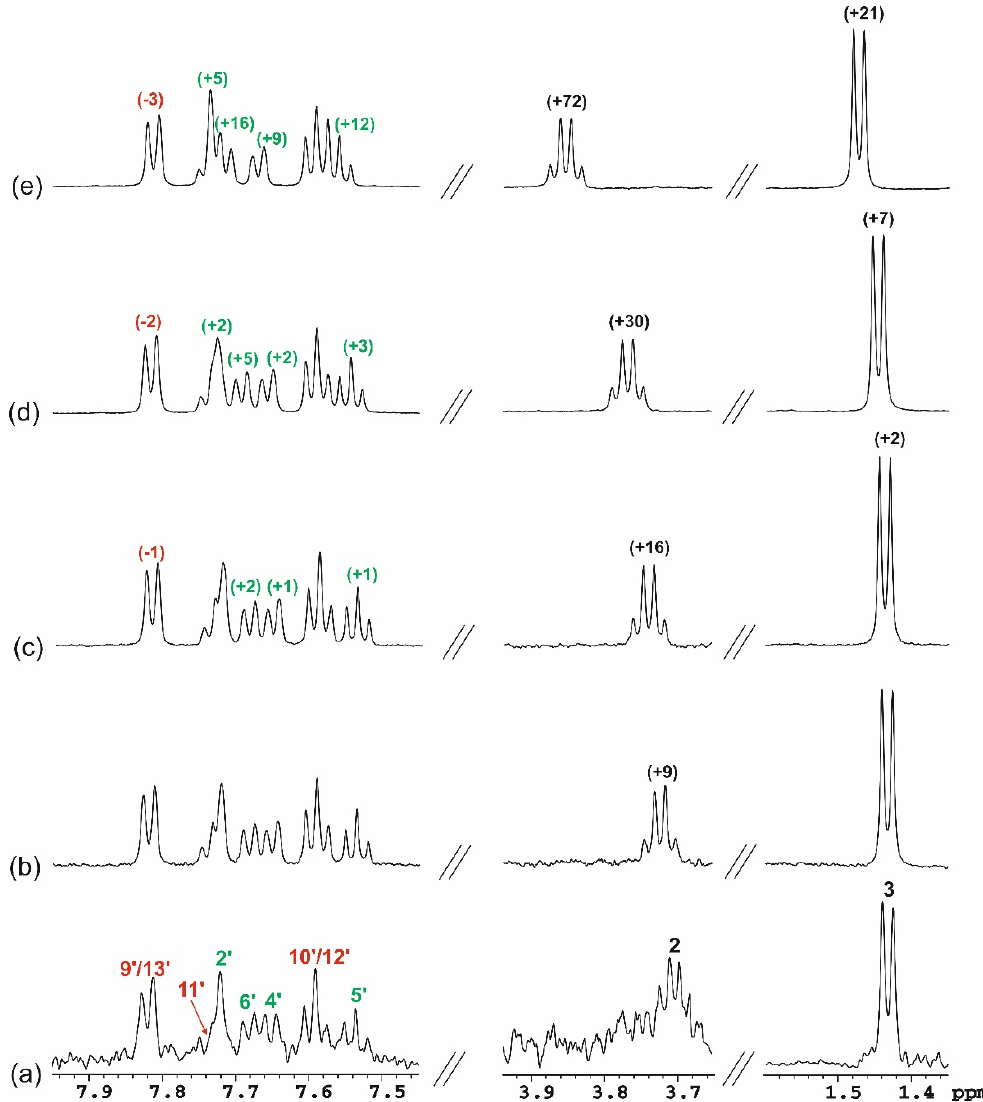
Figure 10. The aromatic (7.40–8.00 ppm) and aliphatic (3.65–3.95 ppm and 1.35–1.60 ppm) fragments of the 1 H NMR spectra of racemic KP aqueous solutions: C KP = 0.001 mM ( a ), C KP = 0.050 mM ( b ), C KP = 0.100 mM ( c ), C KP = 0.340 mM ( d ), C KP = 0.500 mM ( e ); in brackets. ∆ δ are given ( ∆ δ = δ obs − δ 0 is the chemical shift change of proton signals of KP, δ obs = the chemical shift of proton signals of KP at given concentration, δ 0 = the chemical shift of proton signals of KP at 0.001 mM; positive values indicate high-frequency shifts, [Hz]); chemical shift changes of proton signals of aromatic rings A and B are marked in green and red, respectively; temperature of 25 °C.